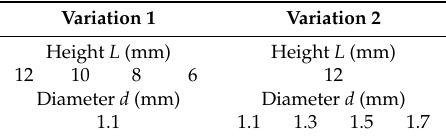
Figure 2. Structural design of the single strut specimen. The test specimen consists of two parallel areas (base and top) and four single struts. The single struts are arranged at an angle of 90 degrees to the base and top area. The crossovers between the base and top area to the single strut are produced with a radius of 1 mm. Table 1. Overview of the geometric parameters for the strut specimen. A first variation with constant diameter ( d ) and variable height and a second variation with constant height ( L ) and variable diameter were designed. All other parameters in both series were constant. All values were derived from CAD data and are given in mm.